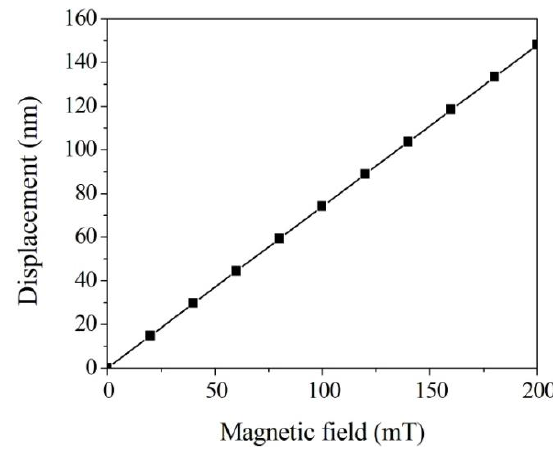
Figure 4. Displacement of interdigitated electrodes in the magnetic sensor.